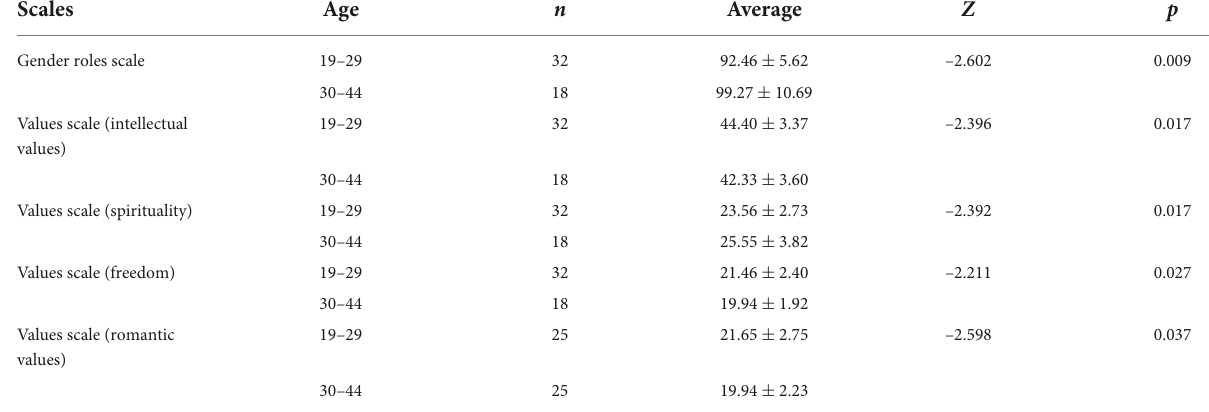
TABLE 3 Relationship between age and scales.